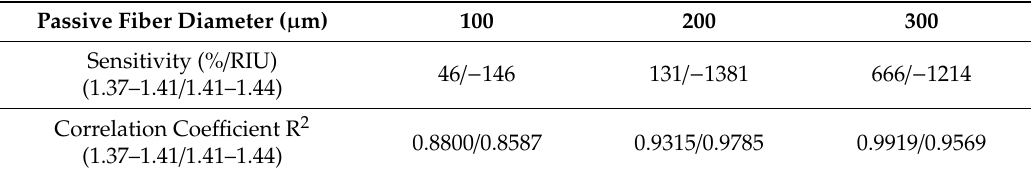
Table 2. The sensitivity results from Figure 5.